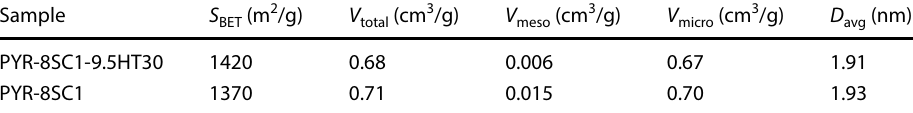
Table 3 The surface area and pore size distribution of ACF